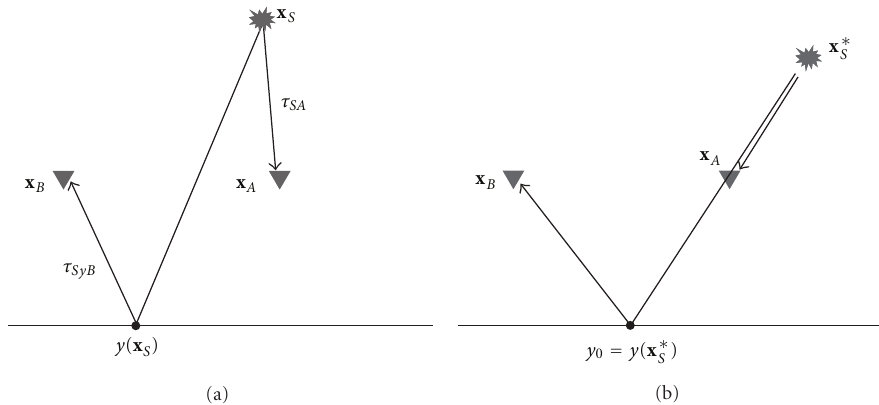
Figure 1: (a) Receiver x A observes direct wave with the travel time τ SA and x B observes reflected wave with τ SyB . The specular reflect position y( x S ) varies with the source position x S . (b) When the source position x S satisfies the stationary phase position x ∗ S , two events have common raypath between x ∗ S and x A